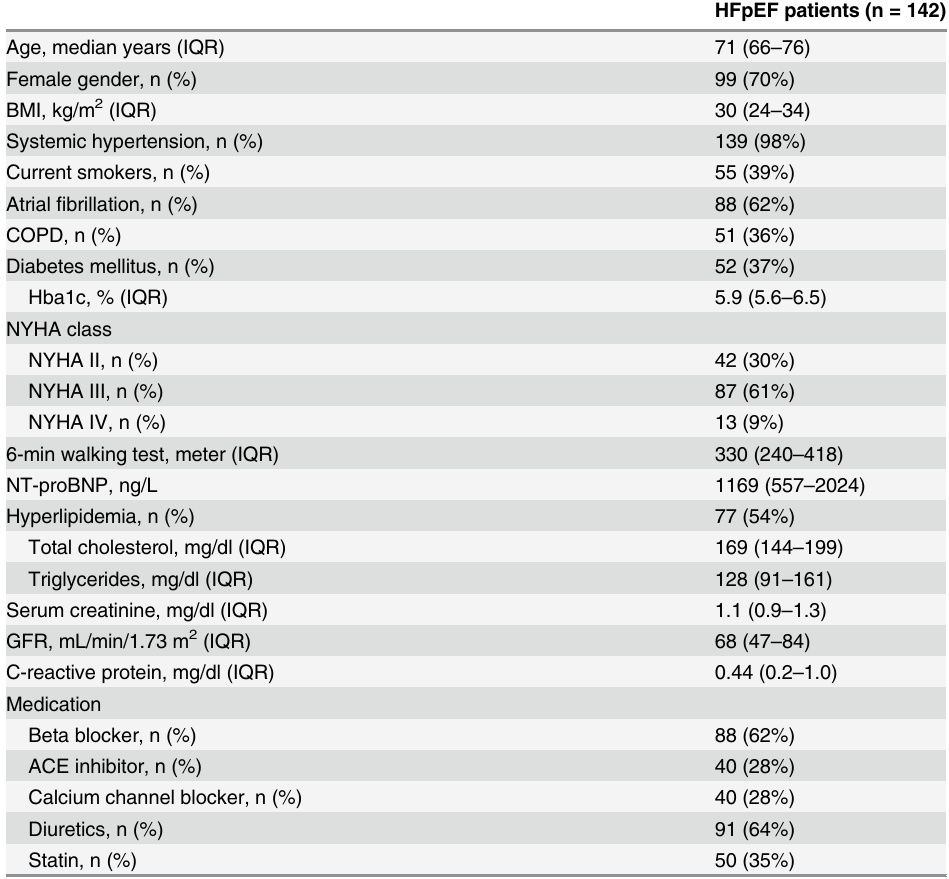
Table 1. Baseline characteristics of patients with HFpEF (n = 142). Continuous variables are given as medians and inter-quartile ranges. Counts are given as numbers and